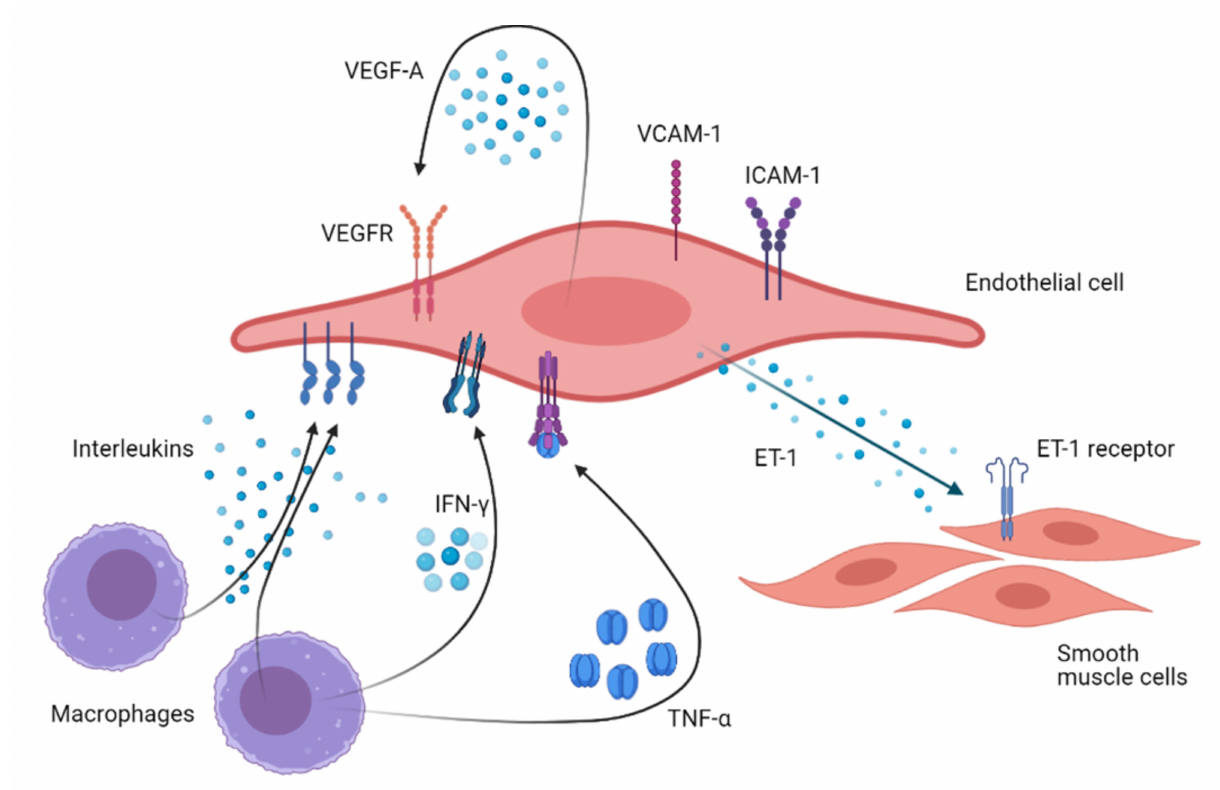
Figure 2. A graphical representation of the paths of endothelial markers involved in male infertility. Footnote to Figure 2: ET-1: endothelin-1; ICAM: intracellular cell adhesion molecules; IFN: interferon; TNF- α : tumor necrosis factor-alpha; VCAM: vascular cell adhesion molecules; VEGF-a: vascular endothelial growth